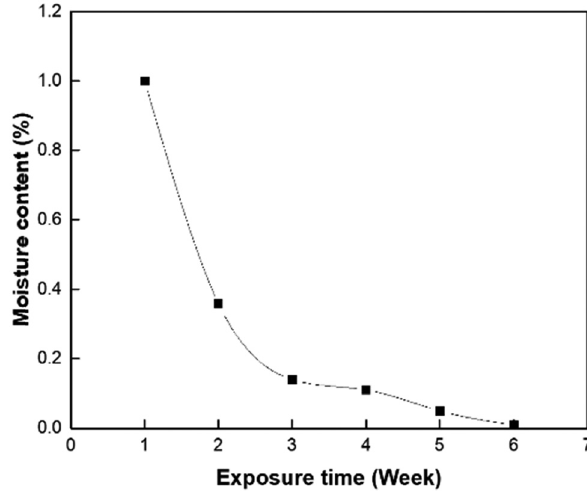
Figure 3: Moisture absorption behavior of the ETW specimens.